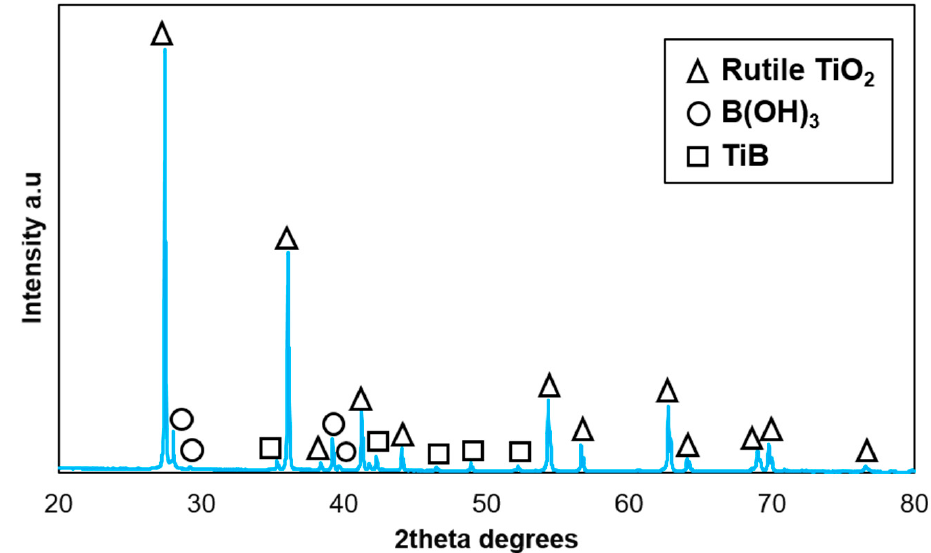
Figure 7. XRD pattern of composite surface after sliding at 800 °C, 20 N.